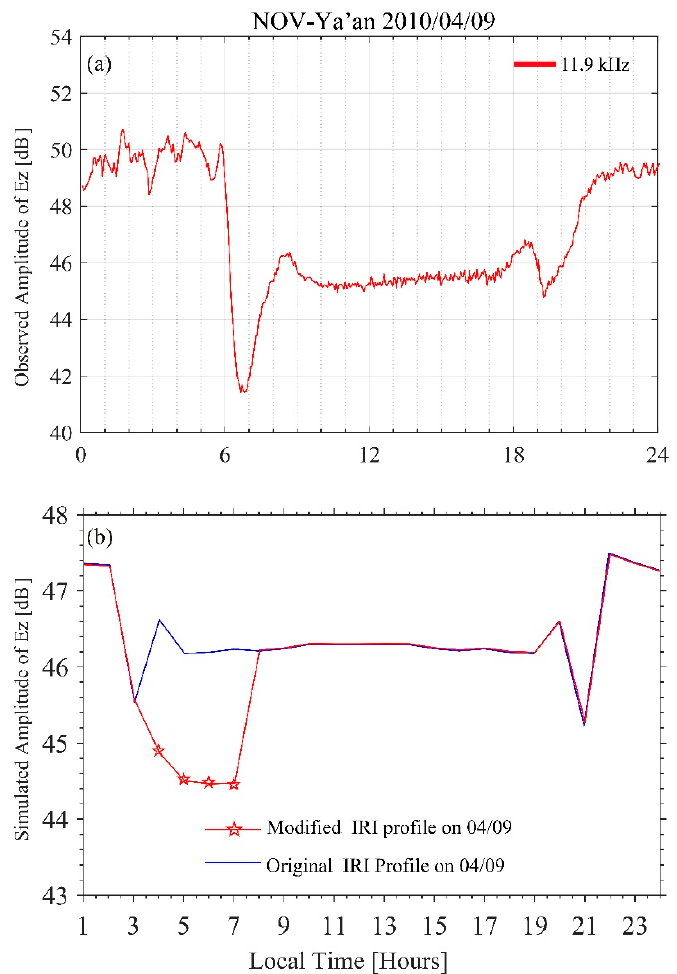
Figure 9. The top panel ( a ) represents the continuous amplitude of Ez (vertical component of electric field) observed on 9 April. The bottom panel ( b ) shows the calculated Ez 2700 km away from the NOV transmitter. In ( b ), the blue solid line shows the calculated Ez under the original IRI profile on 9 April, when sunrise was LT 4:00; the red solid line with pentagrams shows the calculated Ez under the modified IRI profile, when the sunrise time shifted to LT 7:00.